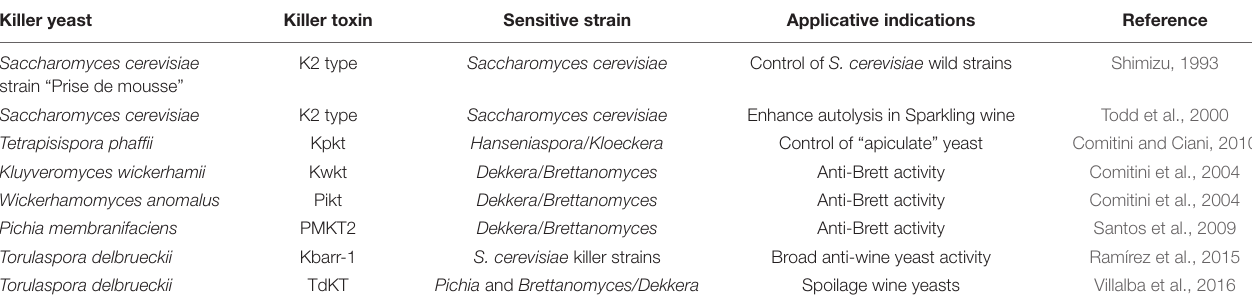
TABLE 1 | Main killer toxins involved in wine